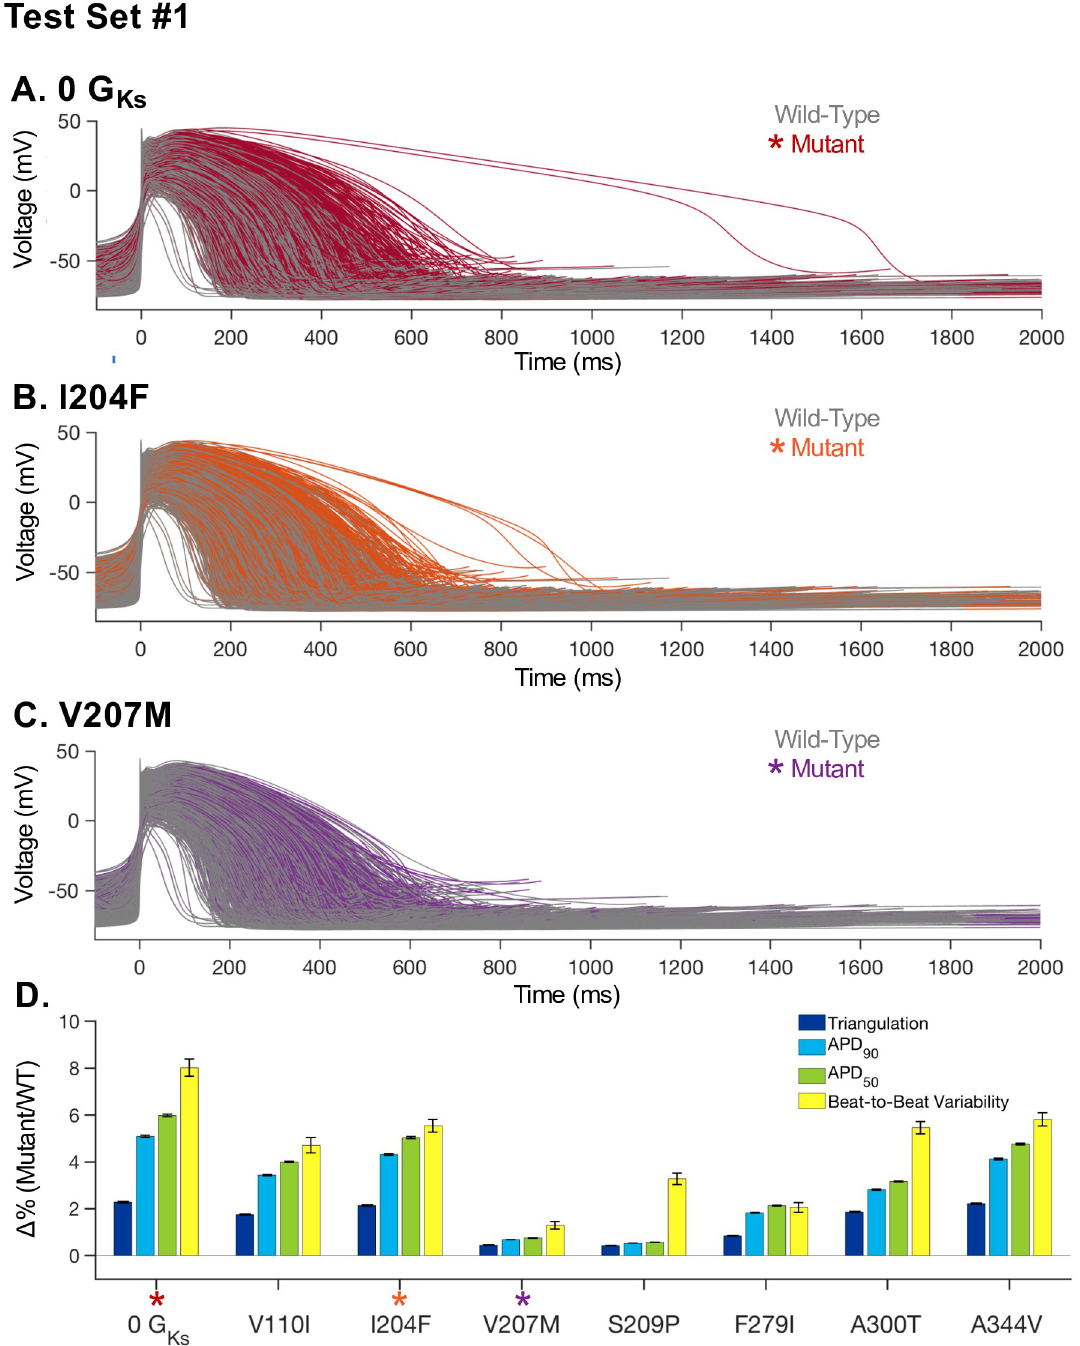
Fig 2. Population-based modeling results for test set 1 mutations in iPSC-CMs computational models. (A) For a random subset of the model population (n = 2818), APs are shown for wild-type (grey) and complete I Ks block (0 G Ks , red). (B) For a random subset of the model population (n = 2826), APs are shown for wild-type (grey) and the I204F mutant (orange). (C) A random subset from the model population (n = 2826) are shown for APs for wild-type (grey) and the V207M mutant (purple). (D) For each mutant cell in TS1, action potential duration 90% (APD 90 ), APD 50 , action potential (AP) triangulation, and APD 90 beat-to-beat variability were computed relative to the wild-type. AP Triangulation (APD 90 -APD 30 ) and beat-to-beat variability (|APD 90 ,n-APD 90 ,n+1|, for beat n) were averaged over 40 beats with a physiological noise current. The bar graph shows the mutant population average and standard deviation for each output. APs for mutations highlighted with colored stars are shown in panel A-C.